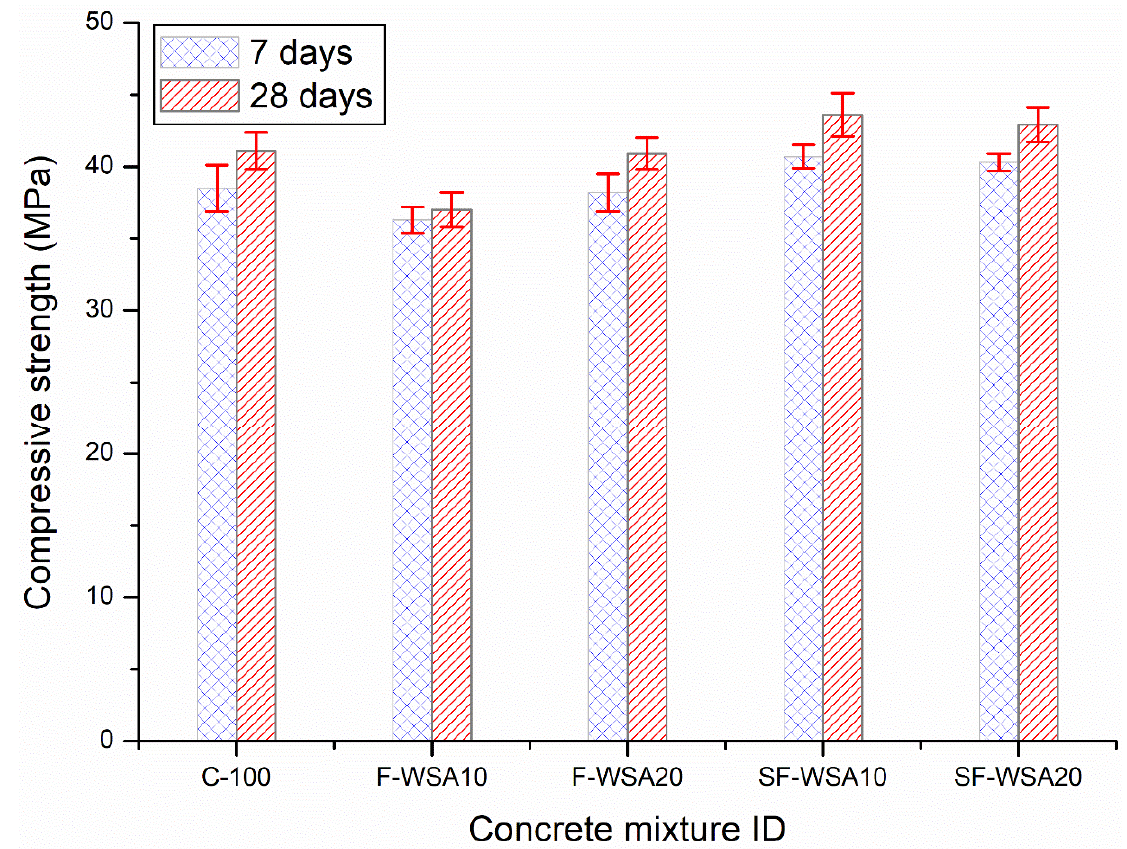
Figure 6. Comparison of 7-day and 28-day compressive strength development between control and concrete containing F-WSA and SF-WSA.